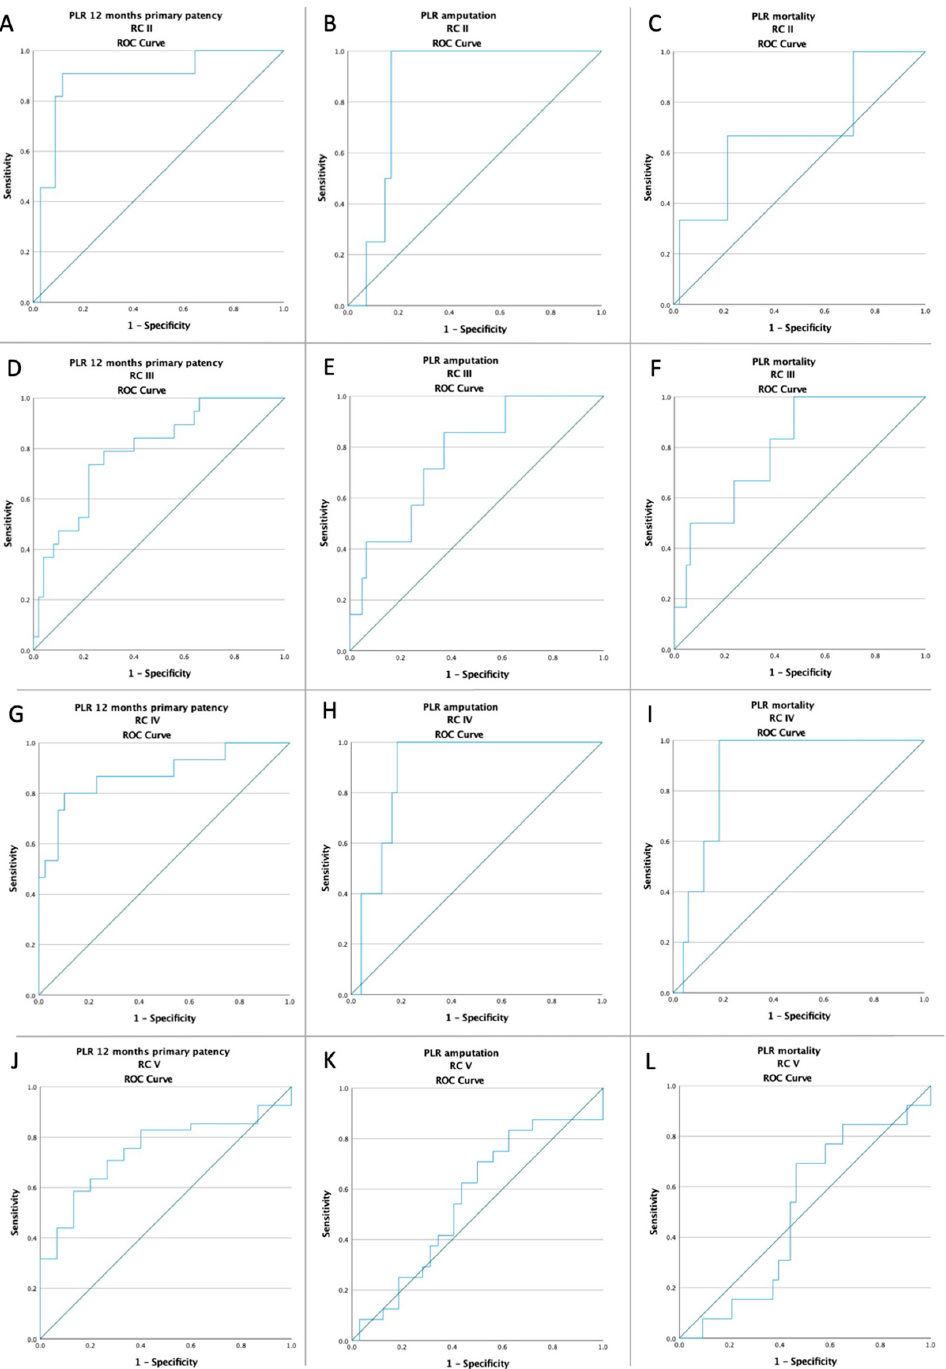
Figure 3. ROC curve analysis ( A ) for PLR with respect to 12 months primary patency in RC 2 patients (AUC: 0.885; p < 0.001), ( B ) for PLR with respect to amputation rate in RC 2 patients (AUC: 0.860; p = 0.019), ( C ) for PLR with respect to mortality rate in RC 2 patients (AUC: 0.683; p = 0.295), ( D ) for PLR with respect to 12 months primary patency in RC 3 patients (AUC: 0.792; p < 0.001), ( E ) for PLR with respect to amputation rate in RC 3 patients (AUC: 0.767; p = 0.02), ( F ) for PLR with respect to mortality rate in RC 3 patients (AUC: 0.799; p = 0.01), ( G ) for PLR with respect to 12 months